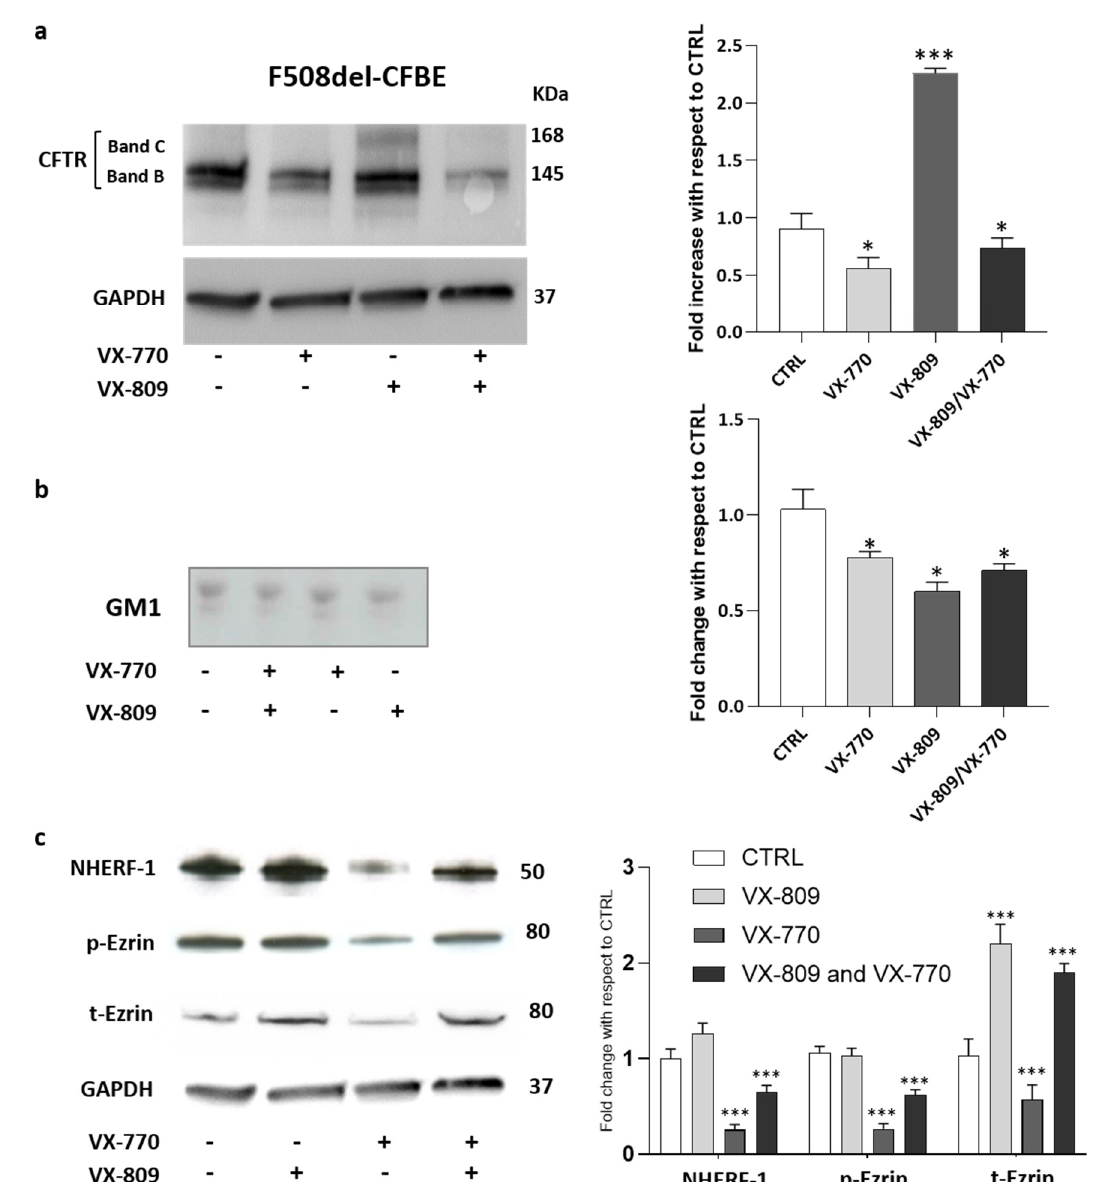
Figure 3. Chronic treatment with VX-770 negatively regulates GM1 levels and the F508del CFTR maturation including the expression of its sca ff olding proteins. CFBE41o- cells overexpressing F508del CFTR were treated for 48 h with 5 µ M VX-770, 1 µ M VX-809 alone or in combination and subjected to the di ff erent analyses: ( a ) representative western blot against CFTR and its quantification; ( b ) representative TLC immunostaining with cholera toxin in order to specifically detect GM1 followed by its quantitative graph; and ( c ) representative western blot against CFTR sca ff olding proteins and its quantification. * p < 0.03 vs. CTRL, *** p < 0.0001 vs. CTRL.